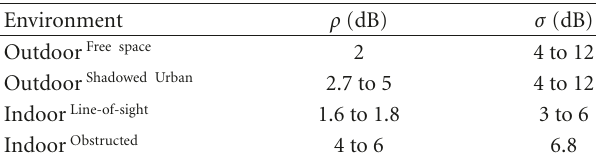
Table 2: Typical values of path loss exponent and shadowing